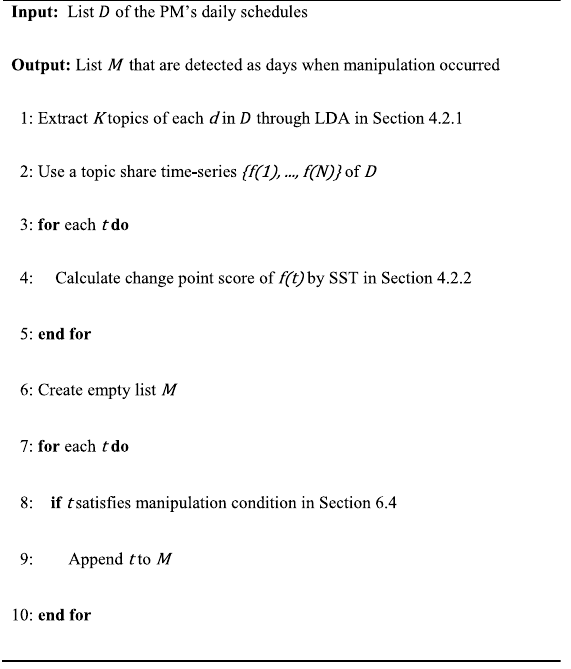
when the pattern of the economic policy topic changes substantially and the share of the economic policy topic increases substantially. The entire proced- ure of TVD for PBCs is summarized as a pseudocode in Algorithm 1.